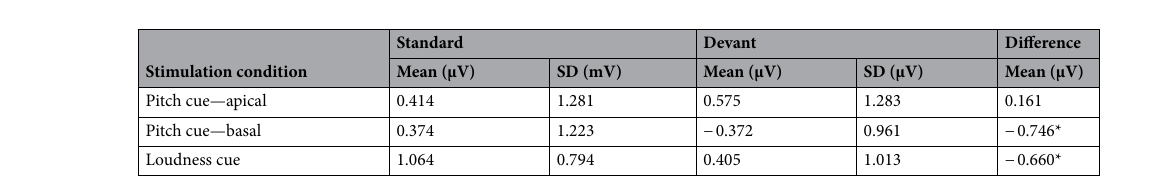
Table 4. Mean amplitudes following standard and deviant stimuli and difference amplitudes. * p < 0.05.